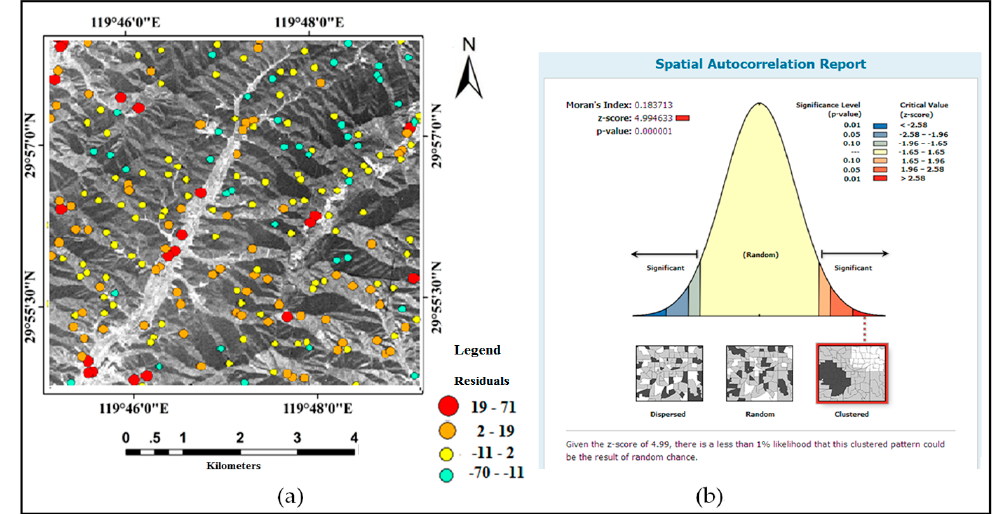
Figure 3. ( a ) Spatial distribution of residual values in CORONA imagery; and ( b ) testing for autocorrelation in regression residuals using Moran’s I